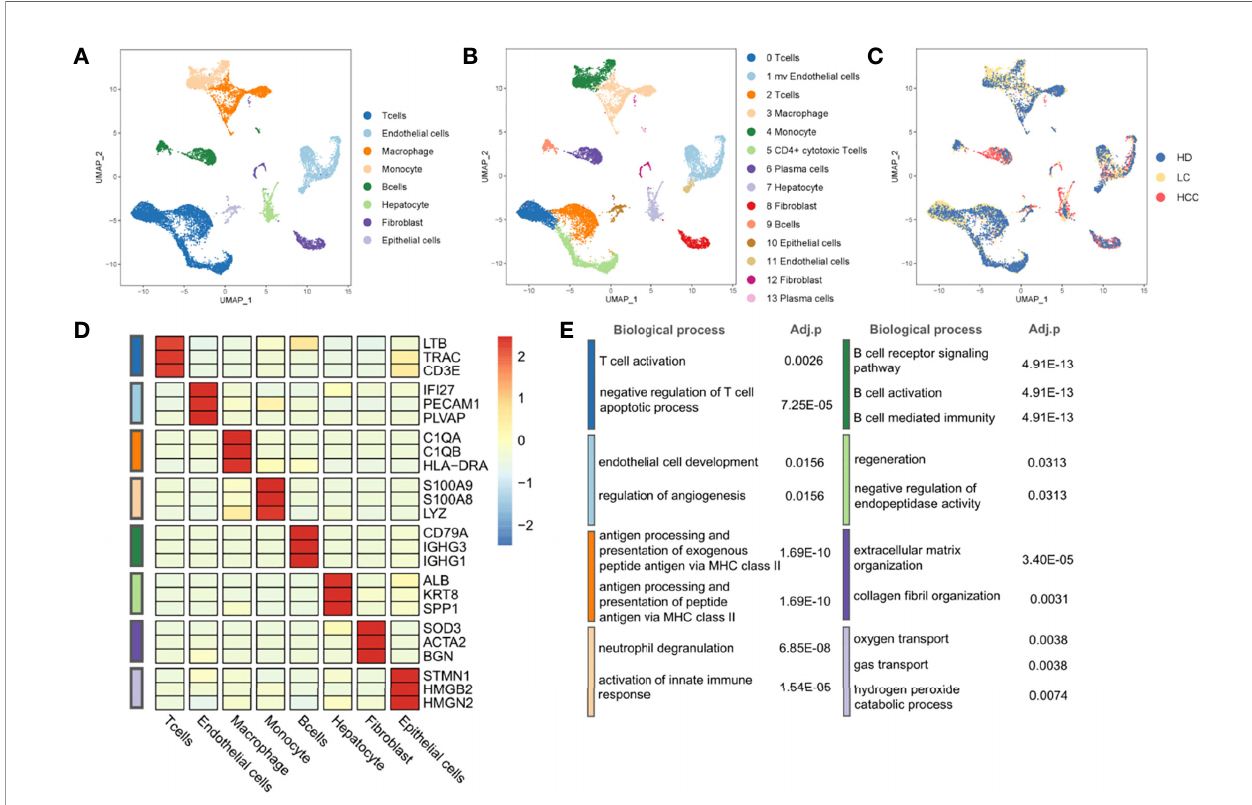
FIGURE 1 | Landscape of liver tissue cells from healthy, cirrhotic and cancerous status. (A) The cells are divided into eight types, including T cells, Endothelial cells, Macrophages, Monocytes, B cells, Hepatocytes, Fibroblasts, and Epithelial cells. (B) Cell clustering through U-map dimensionality reduction, in which 14 clusters are divided, including three subtypes of T cells, two subtypes of Endothelial cells, two subtypes of Fibroblasts, two subtypes of B cells. (C) UMAP plot (in color) of 13,872 single cells from healthy donors (HD), liver cirrhosis (LC) and patients with hepatocellular carcinoma (HCC). (D) Heatmap of marker gene expression of eight cell types. (E) GO functional enrichment analysis of markers in eight cell types, p.adjust < 0.05. P.adjust were calculated using Benjamini and Hochberg method. (The color of the legend in (D, E) is consistent with that in (A)